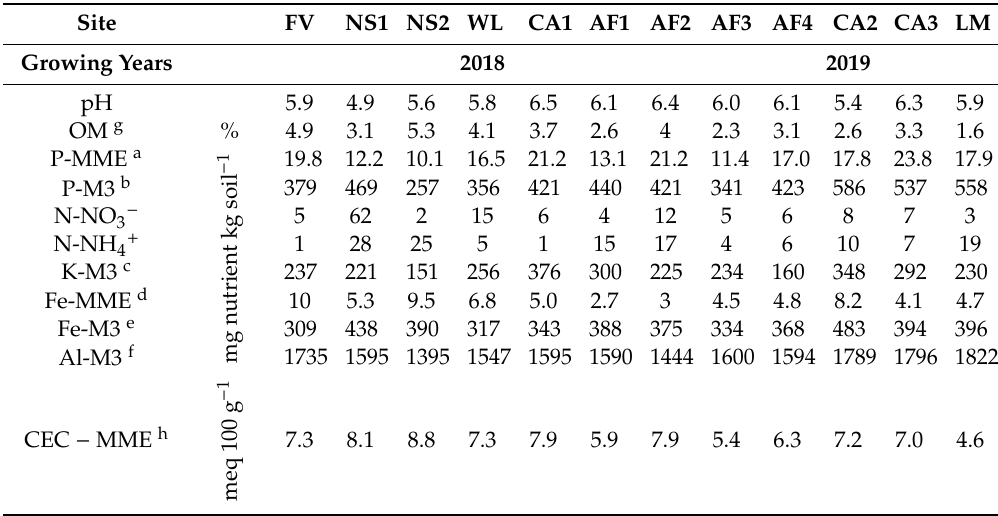
Table 2. Soil chemical properties from the experimental sites in 2018 and